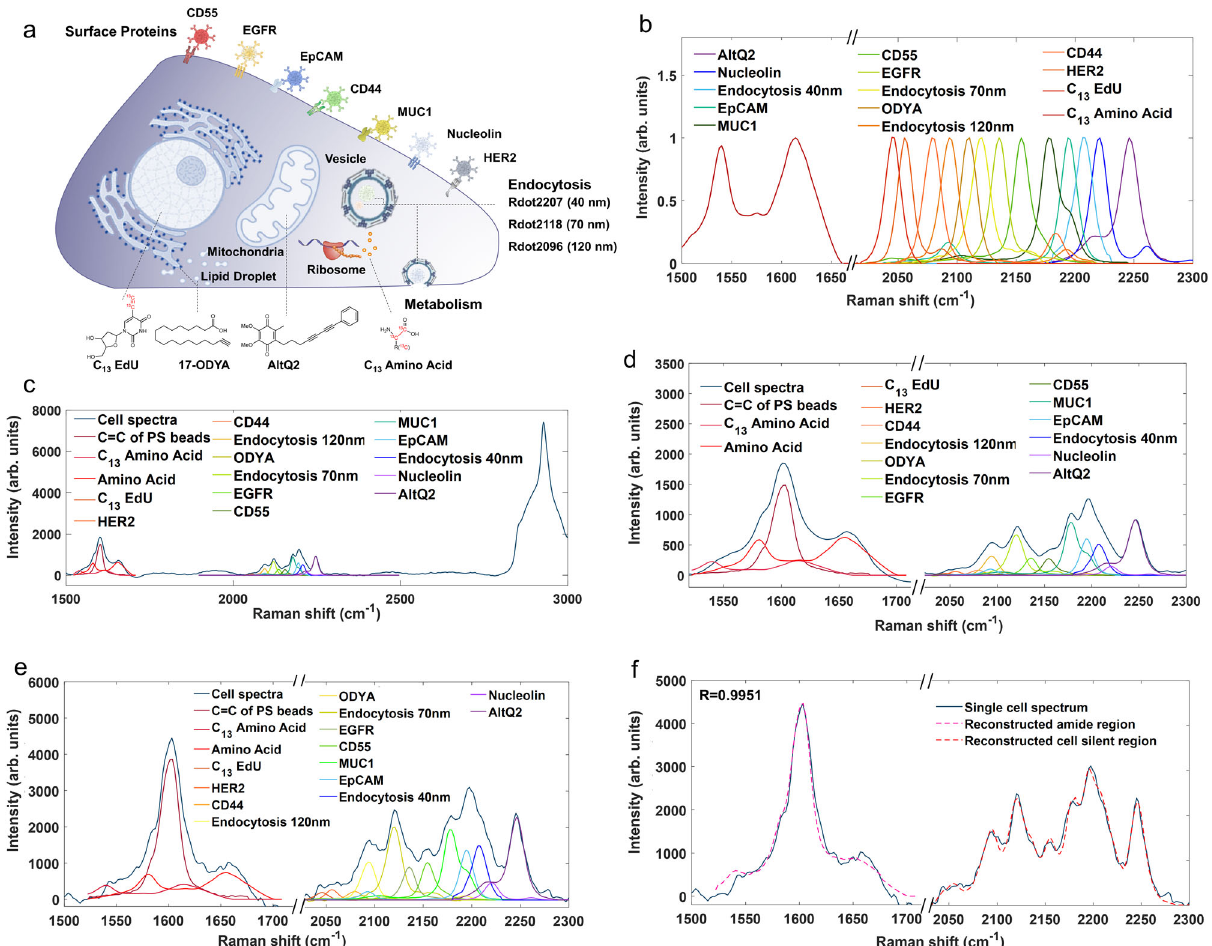
Fig. 5 Principle and implementation of multiparameter Raman pro fi ling of individual living cells. a Diagram illustrating the cellular localization of 14 Raman probes for multiparameter live-cell pro fi ling. b Normalized Raman peaks of 14 Raman probes with distinct frequencies. c , d 14-plexed live-cell Raman spectra with unmixing processing ( c ) and zoom-in view of cell amide and silent window ( d ), averaged over 213 individual cells. e , f Zoom-in view of single live-cell Raman spectrum with unmixing processing ( e ) and reconstructed amide and cell-silent region ( f ), the Pearson correlation ef fi cient between reconstructed and original spectra R =